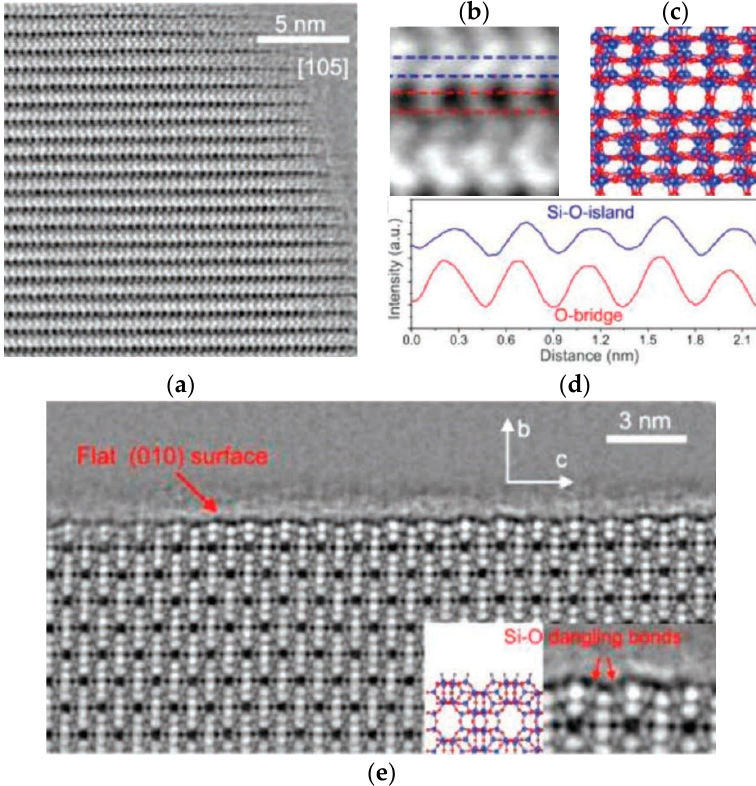
Figure 10. ( a ) The iDPC-STEM image of ZSM-5 from the <105> direction; ( b – d ) detailed analysis from ( a ); ( e ) the atomically flat (010) surface with clear Si-O dangling bonds. Reprinted/adapted with permission from Ref. [94]. Copyright 2019, Advanced